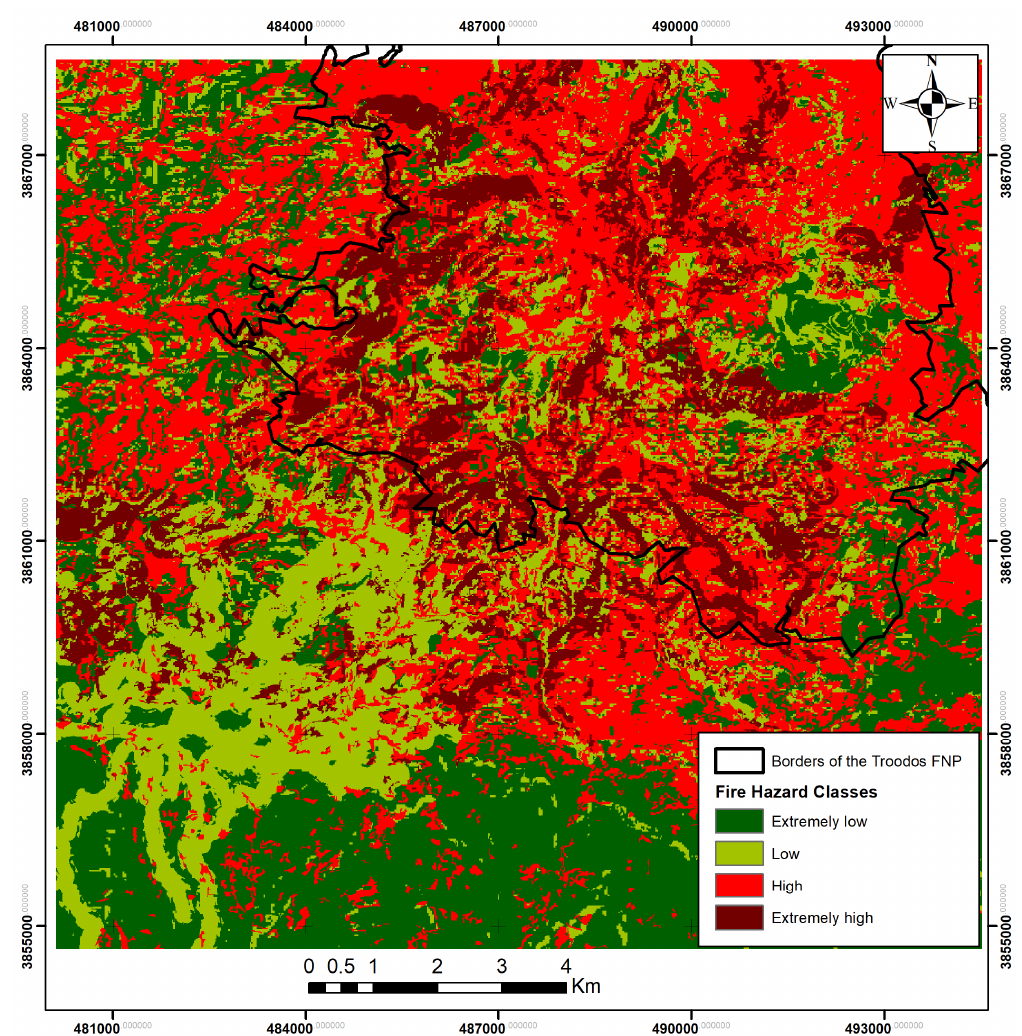
Figure 5. Fire hazard map of the study area. Coordinate System: WGS_1984_UTM_Zone_36N. Fire 2020 , 3 , 31